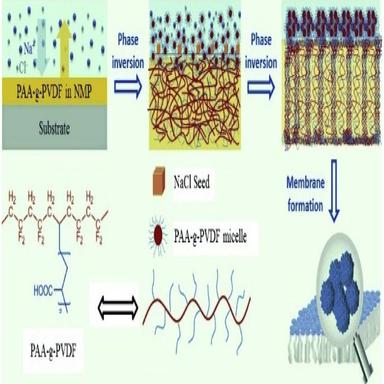
Process of the synthesis of the superhydrophilic and underwater superoleophobic PAA-g-PVDF membrane by salt phase inversion.